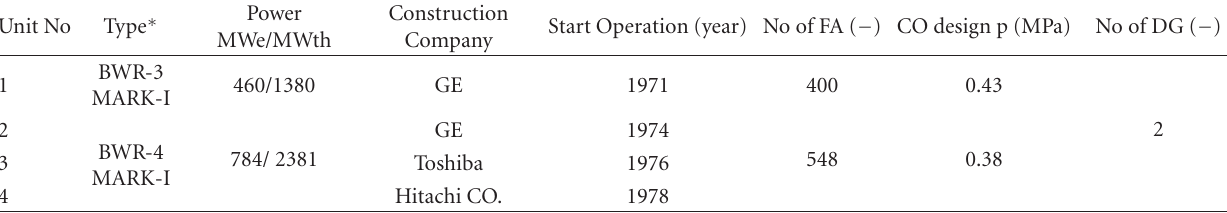
Table 1: Key features of the Fukushima Units 1 to